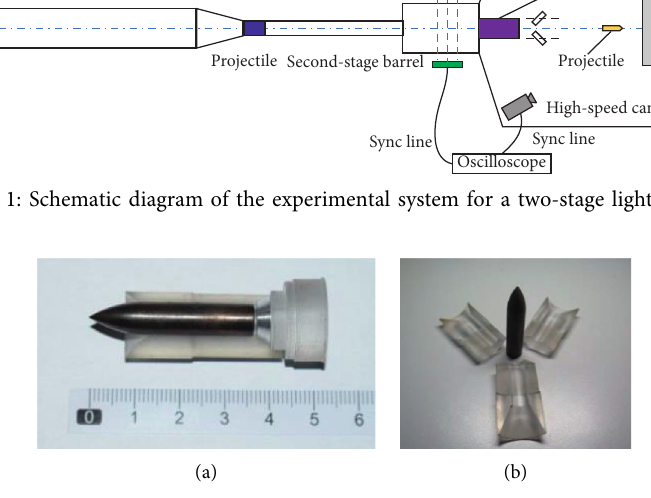
Figure 2: Photographs of the projectile with sabots.